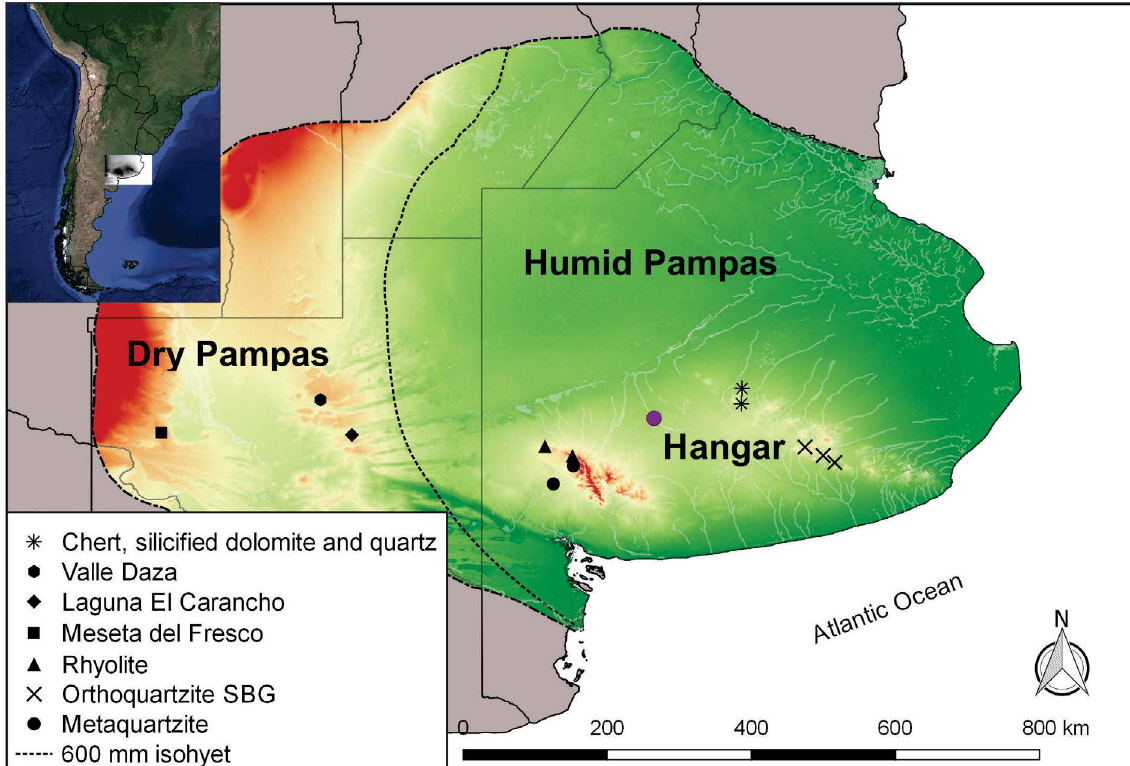
Figure 1. Location of Hangar site and the lithic raw material